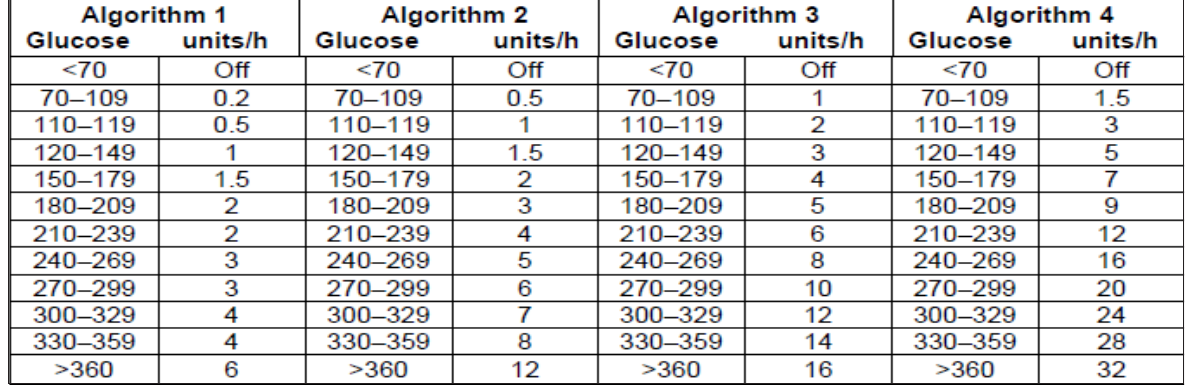
o Algorithm 1: Start here for most patients. o Algorithm 2: Start here if receiving glucocorticoids, previously on high TDD of insulin etc. • Moving algorithms: o Moving up: When glucose remains outside the target range after titrating insulin. o Moving down: When glucose is <110 mg/dL × 2 or decreases >60 mg/dl in 1 hour.